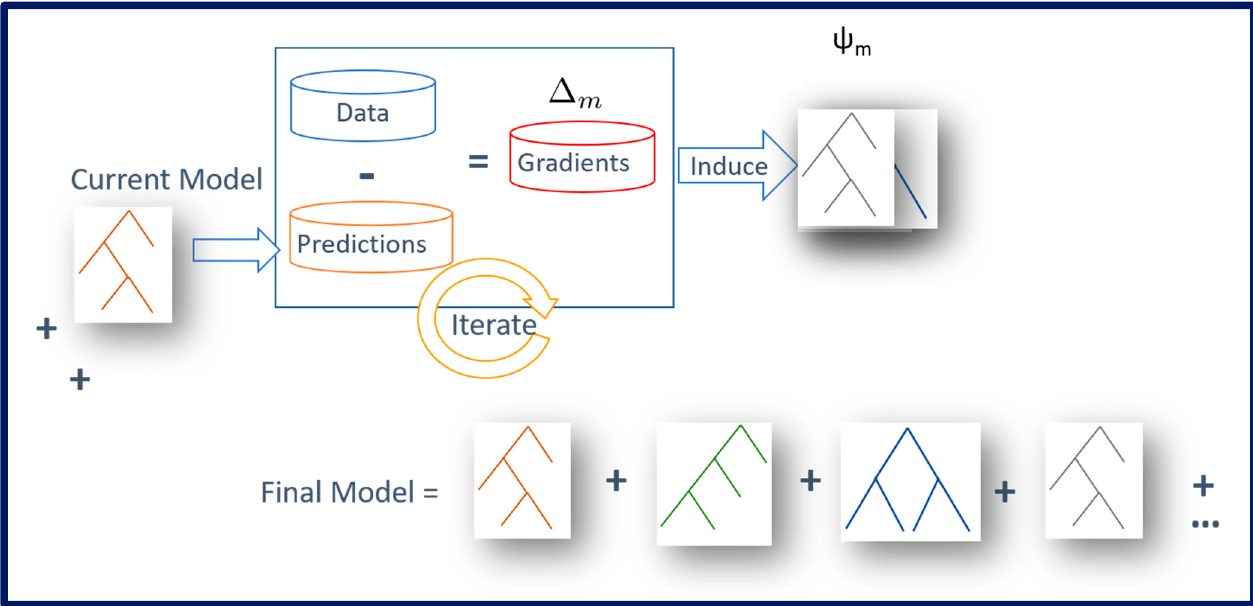
Figure 1. Illustration of functional gradient boosting where the classifier is constructed in a stage-wise process. At each iteration, prediction errors are computed for each training example based on the current model. Then, a simple regression model (typically a small tree) is created to correct the errors and the process is repeated until convergence. In contrast to standard gradient-based methods, the functional gradients are point-wise gradients computed for each example separately as against the entire data set. This allows for both e ffi cient and e ff ective learning from large data sets.